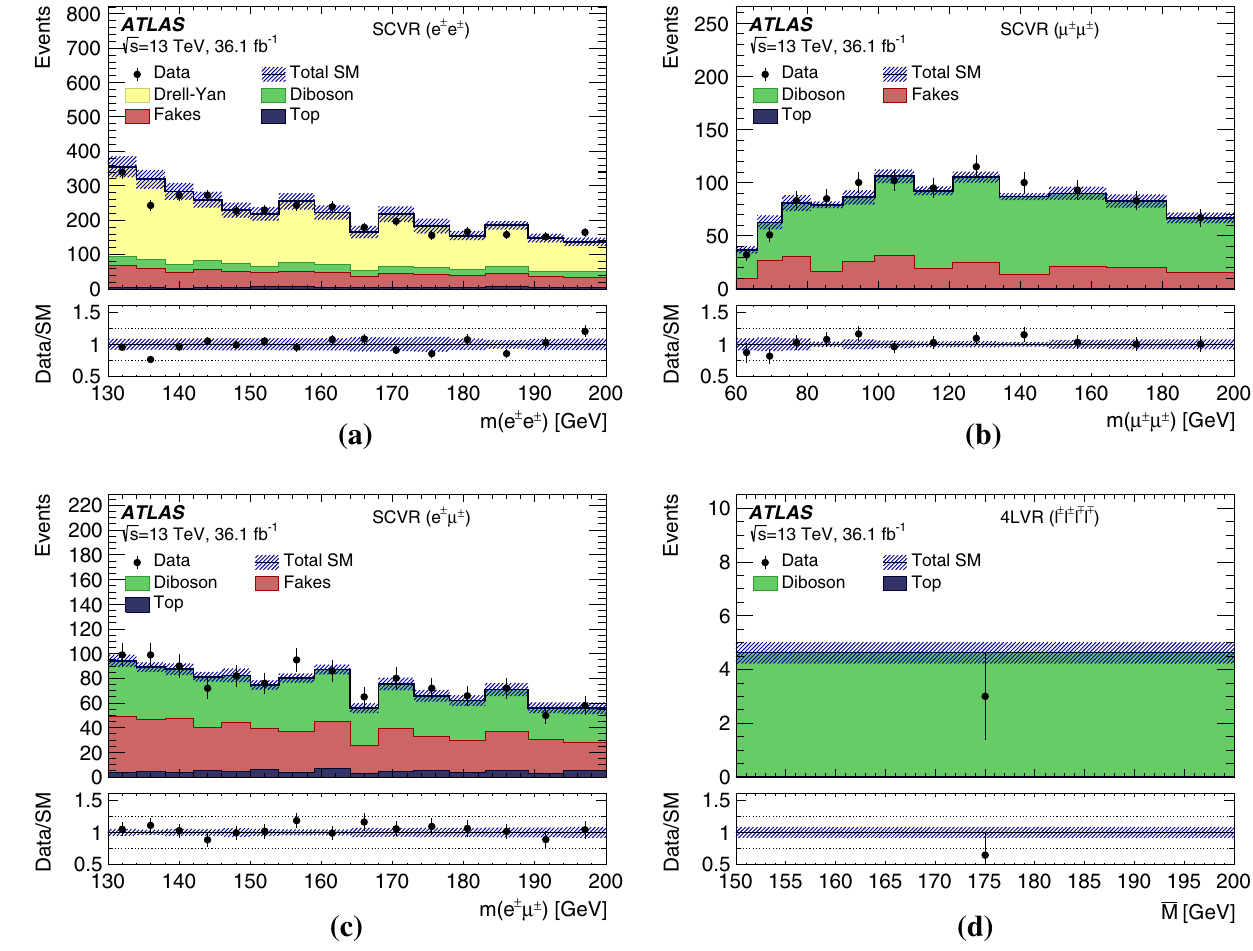
Fig. 4 Distributions of dilepton mass for data and SM background predictions in two- and four-lepton validation regions: a the electron– electron, b themuon–muon,and c theelectron–muontwo-leptonvalida-